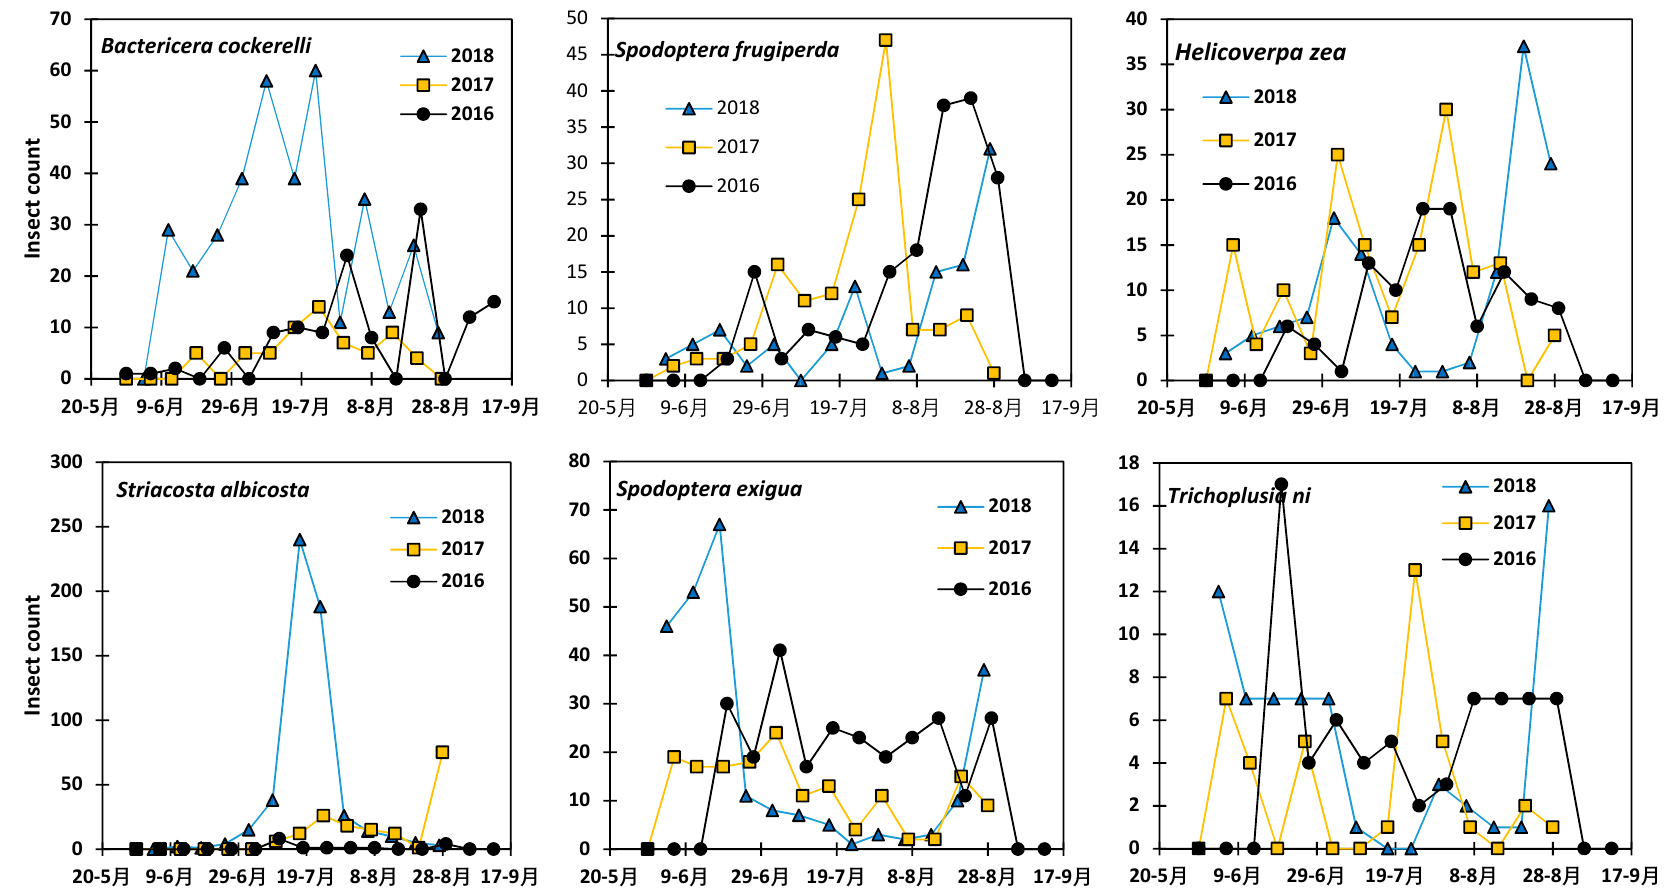
Figure 3. Variation in the population density of six insect pests at New Mexico State University Agricultural Science Center at Farmington during the 2016–2018 cropping periods.